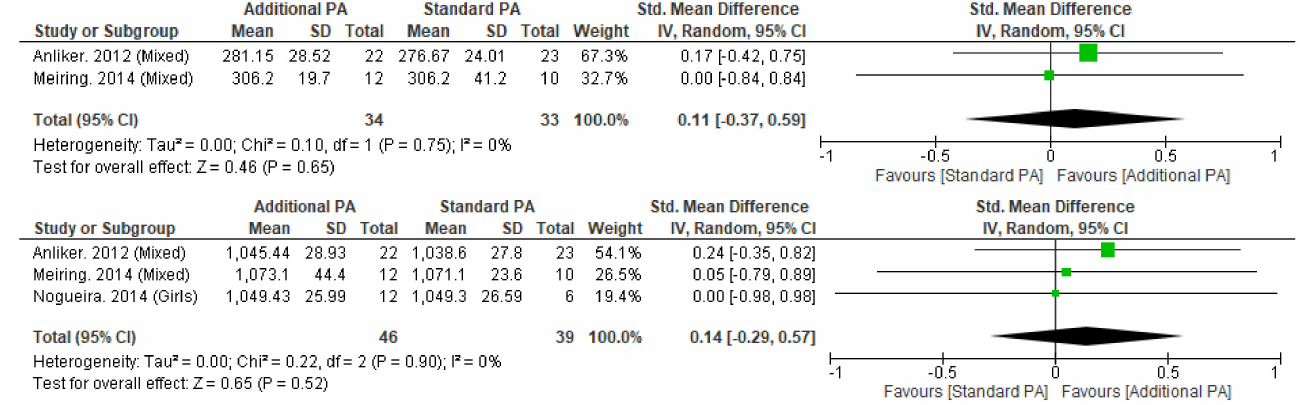
Figure 4. Effect of additional exercise interventions on volumetric bone mineral density at less than 12 months follow-up measures. ( Top ) 4% Tibia, ( Bottom ) 38% Tibia. Legend: PA = Physical Activity, Std = standardised, IV = inverse variance, SD- standard deviation, CI = confidence